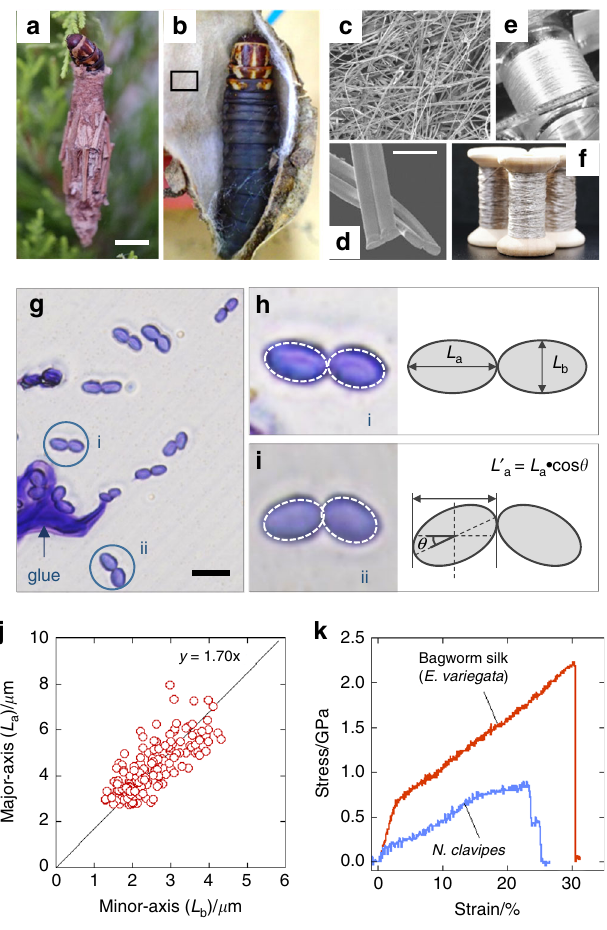
Fig. 1 Morphological and mechanical characteristics of the bagworm silk. Photographs of a exterior and b interior of larval house (or nest) of a last- instar female larva of E . variegata . c SEM image of inner surface of the larval house (from rectangular part in b ). d Magni fi ed SEM image of single fi bres with their cross-sections. e Continuous bagworm silk wound on a bobbin, and f its twisted yarn. g Optical micrograph of cross-sections of bagworm silks. Typical cross-sections of a single fi bre composed of h , a pair of straight conjugated fi laments, and i a pair of fi laments conjugated with a tilting angle θ , are shown together with schematic illustrations. In each fi lament in h , i , the cross-section is traced by an elliptical shape with a broken line. j Plot of axial ratios of lengths of major and minor axes in elliptical cross-sections of bagworm silk. The straight line with a slope of 1.70 was obtained by linear regression for the plots. k Typical stress – strain curve of single bagworm silks. For comparison, a typical stress – strain curve of N . clavipes dragline silk, measured in this study using the same procedure and instruments used for bagworm silks, is included. The average tensile properties of N . clavipes ( n = 5) were as follows: modulus = 8.13 GPa, strength = 0.9 GPa, extensibility = 0.26, and toughness = 139.7 MJ m − 3